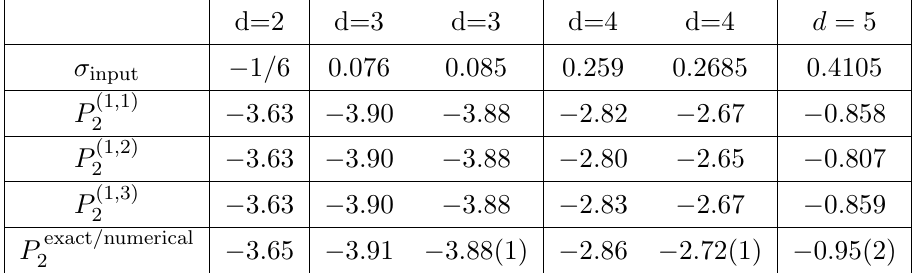
Table 5 . The (cid:12)rst order estimates of the OPE coe(cid:14)cient P 2 of the Lee-Yang CFTs in various dimensions and the exact value [104] or the numerical values from conformal bootstrap [77, 78]. We only show three signi(cid:12)cant (cid:12)gures of the estimates. The estimates are most accurate in three dimensional spacetime. The estimates in 5d seem to be the least accurate.